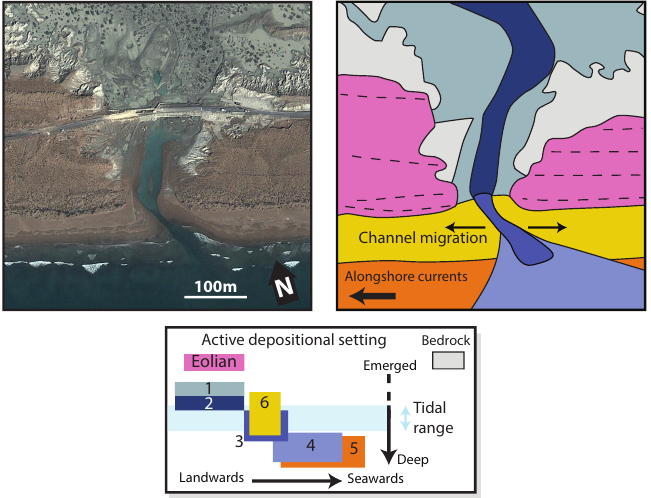
Figure 6. Beris Beach, interpretation of the described facies depositional environment (based on Figure 4C). Black dashed lines: beach ridges. Facies numbering is as reported in Table